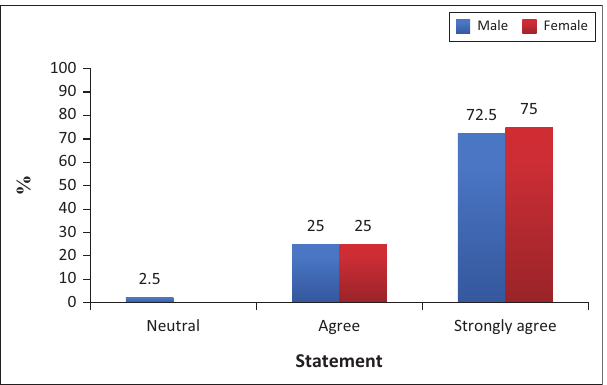
FIGURE 2: Water shortage during